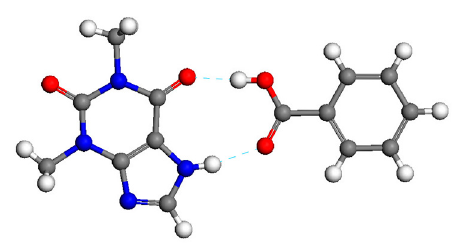
Figure 1. The molecules of theophylline-benzoic acid (TP-BA) cocrystal at a stoichiometric molar ratio of 1:1 (grey atoms: C; red atoms: O; blue atoms: N; white atoms: H).